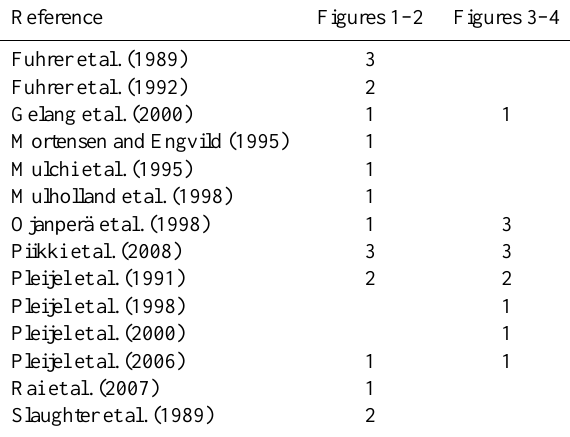
Table 1. References used to extract data for Figs. 1–2 and Figs. 3– 4 as well as the number of experiments used deriving from each